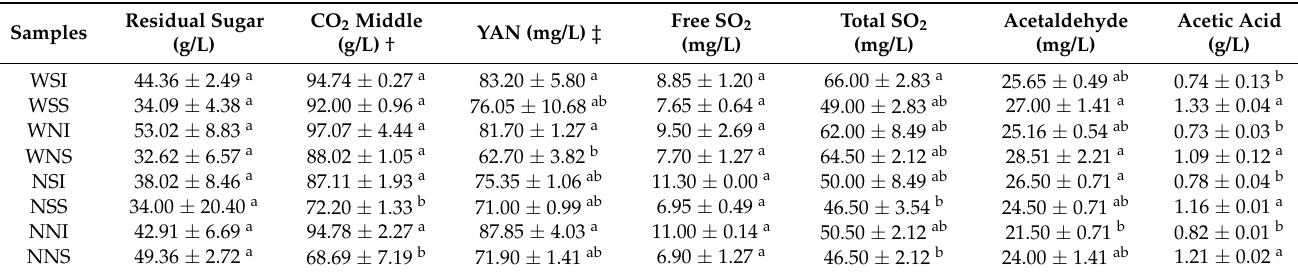
Table 1. Chemical analysis of wines obtained with spontaneous (S) and inoculated (I) microvinification trials of four grape musts. Washed grapes with SO 2 (WSS and WSI), washed grapes without SO 2 (WNS and WNI), non-washed grapes with SO 2 (NSS and NSI), non-washed grapes without SO 2 (NNS and NNI). Data are represented as the mean ± standard deviation of two